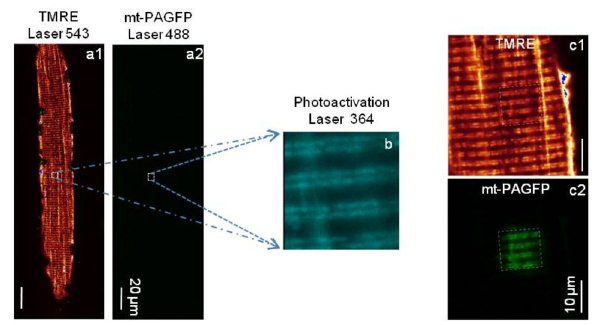
Figure 1. Photoactivation of mt-PAGFP. Simultaneous recording of TMRE (a1) and mt-PAGFP (a2) images. Before photoactivation, there is no GFP fluorescence of mt-PAGFP detected in a2 . A small area (~ 10 X 10 µm 2 ) of the fiber was photoactivated by a 364 nm laser ( b ). After photoactivation, the fiber was imaged again simultaneously for both TMRE (c1) and mt-PAGFP (c2) at the fiber region including the area with photoactivated GFP. Note the visible GFP fluorescence of mt- PAGFP in c2 recorded at the same laser intensity as in a2 .